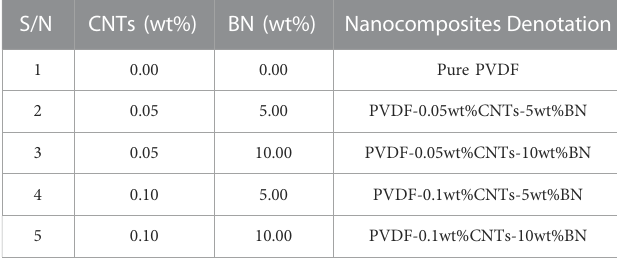
TABLE 1 Nanocomposites preparation